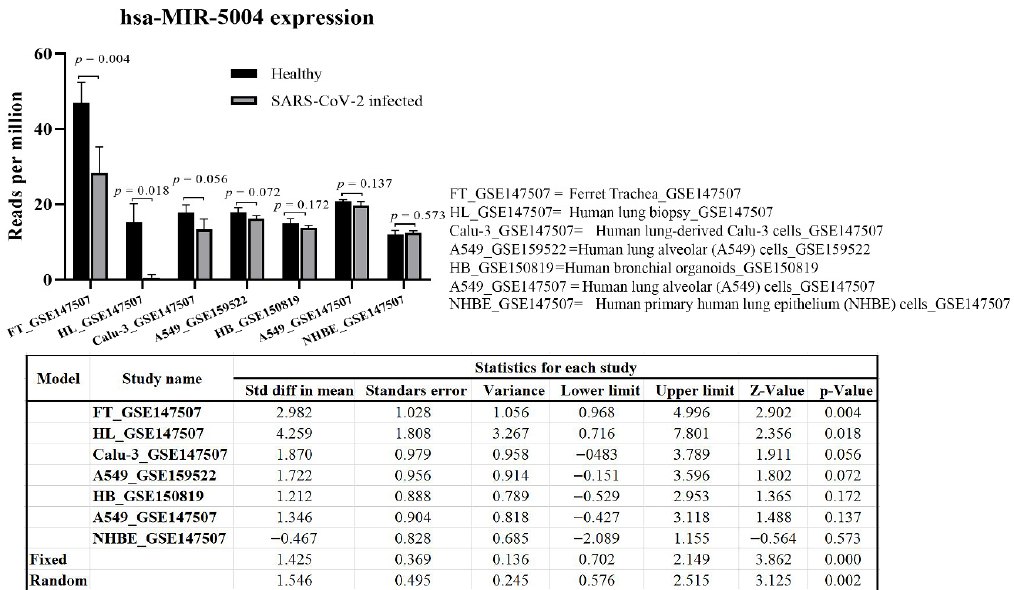
Figure 8. hsa − MIR − 5004 expression response to SARS − CoV − 2 infection. Meta − analysis revealed a significant ( p < 0.01) Figure 8. hsa-MIR-5004 expression response to SARS-CoV-2 infection. Meta-analysis revealed a significant ( p < 0.01) decline decline in expression of hsa − MIR − 5004 after SARS − COV − 2 infection. hsa − MIR − 5004 expression was studied in 42 samples in expression of hsa-MIR-5004 after SARS-COV-2 infection. hsa-MIR-5004 expression was studied in 42 samples of trachea, of trachea, lung biopsy, lung − derived Calu − 3 cells, and lung alveolar A549 cells before and after SARS − CoV − 2 infection. lung biopsy, lung-derived Calu-3 cells, and lung alveolar A549 cells before and after SARS-CoV-2